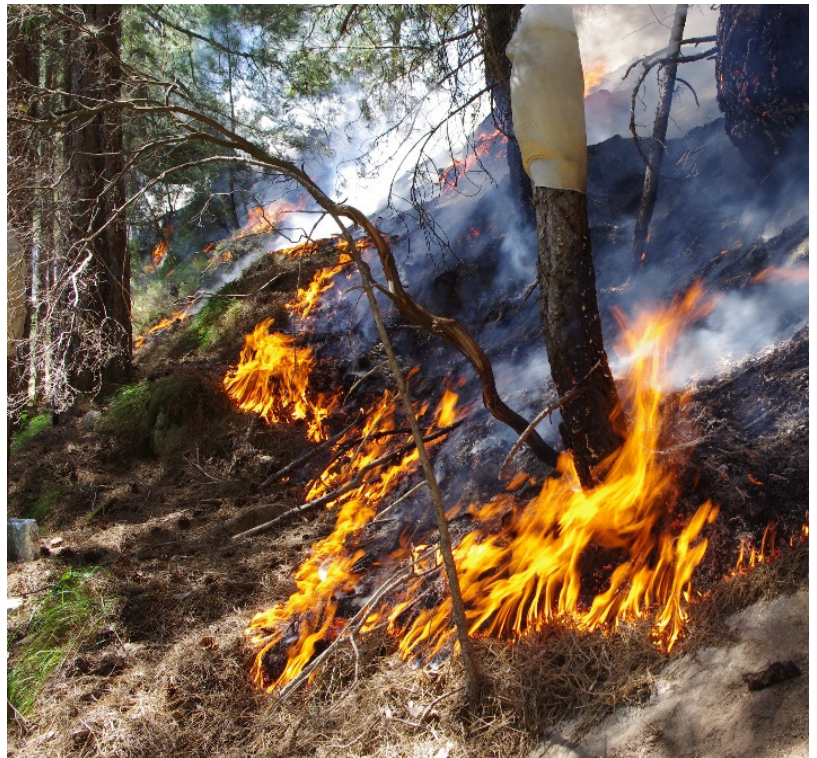
Figure 2. The backing flames of the prescribed fire burned pine needle litter and herbaceous strata. The fire’s rate of spread was estimated to be in the range of 0.60–0.84 m/min. Fireline intensity varies in time and space, and the average value was estimated to be between 110 and 160 kW m – 1 , based on surface fuel load and the fire’s rate of spread. A typical example of temperature evolution at both the outer and inner bark surfaces is presented in Figure 3.